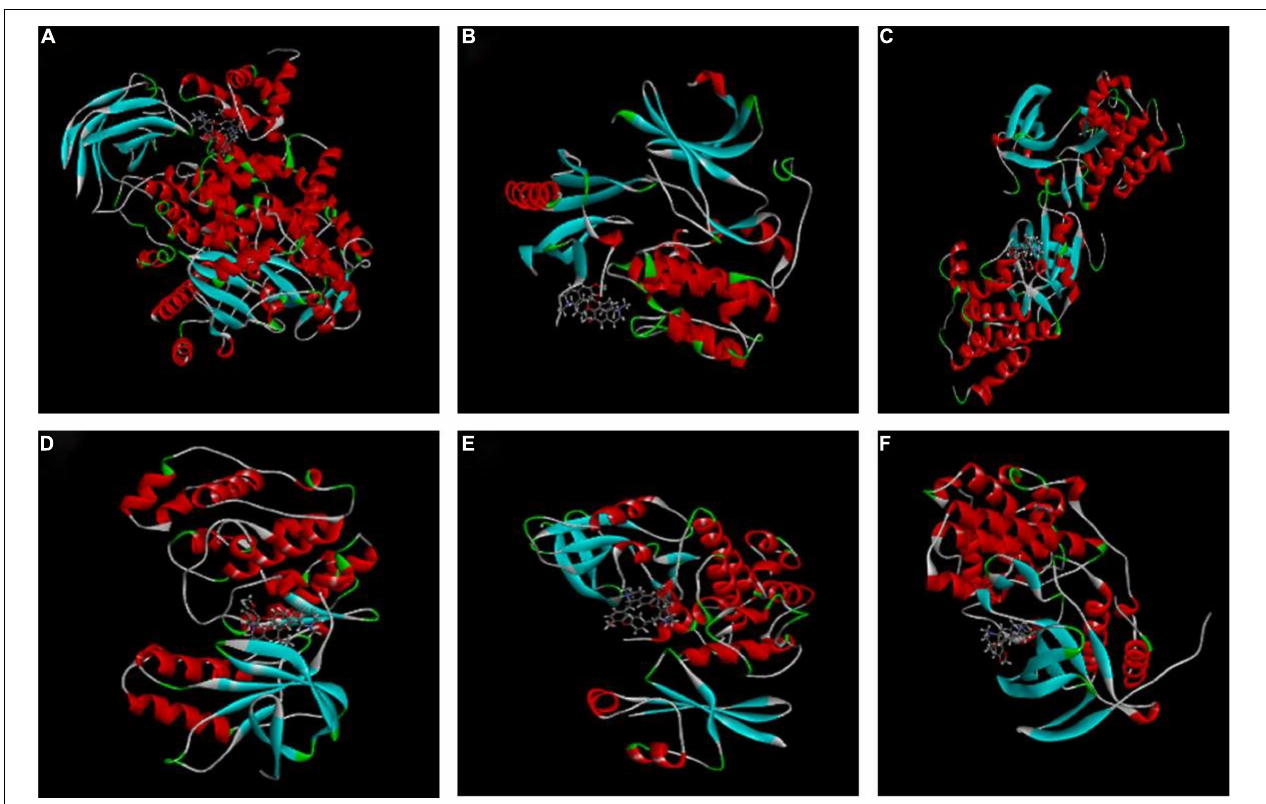
FIGURE 4 | Molecular docking of CEP to potential targets. (A) CEP and PIK3CG (3pre). (B) CEP and AKT1 (6hhh). (C) CEP and SRC (2BDF). (D) CEP and P38 (1a9u). (E) CEP and CDK1 (6GU6). (F) CEP and MAPK14 (5eti).